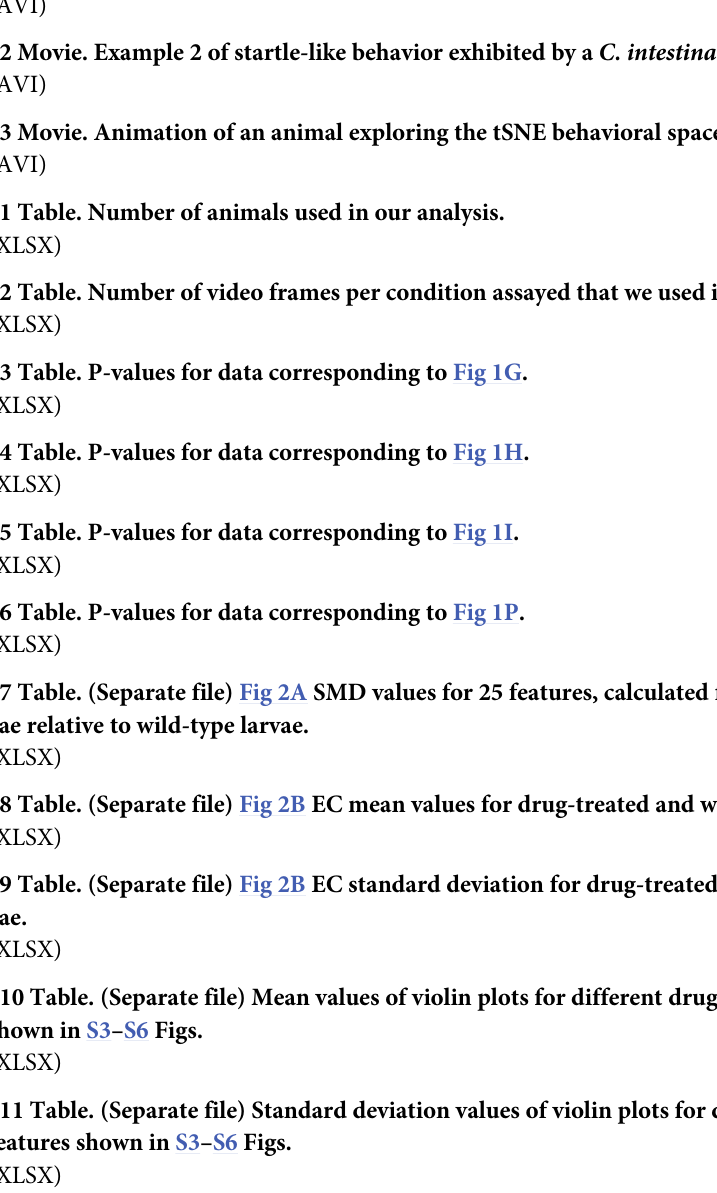
S1 Table. Number of animals used in our analysis. S2 Table. Number of video frames per condition assayed that we used in our analysis. (XLSX) S3 Table. P-values for data corresponding to Fig 1G. S4 Table. P-values for data corresponding to Fig 1H. S5 Table. P-values for data corresponding to Fig 1I. S6 Table. P-values for data corresponding to Fig 1P. S7 Table. (Separate file) Fig 2A SMD values for 25 features, calculated for drug-treated lar- vae relative to wild-type larvae. S8 Table. (Separate file) Fig 2B EC mean values for drug-treated and wild-type larvae. (XLSX) S9 Table. (Separate file) Fig 2B EC standard deviation for drug-treated and wild-type lar- vae. S10 Table. (Separate file) Mean values of violin plots for different drugs and features shown in S3–S6 Figs. S11 Table. (Separate file) Standard deviation values of violin plots for different drugs and features shown in S3–S6 Figs. S12 Table. (Separate file) Shapiro–Wilk tests for normality analysis of the data shown in S3–S6 Figs. S13 Table. (Separate file) Mann–Whitney U 2-sided tests with Bonferroni correction for statistical significance analysis of the data shown in S3–S6 Figs. S14 Table. (Separate file) Mann–Whitney U 1-sided (less) tests with Bonferroni correction for statistical significance analysis of the data shown in S3–S6